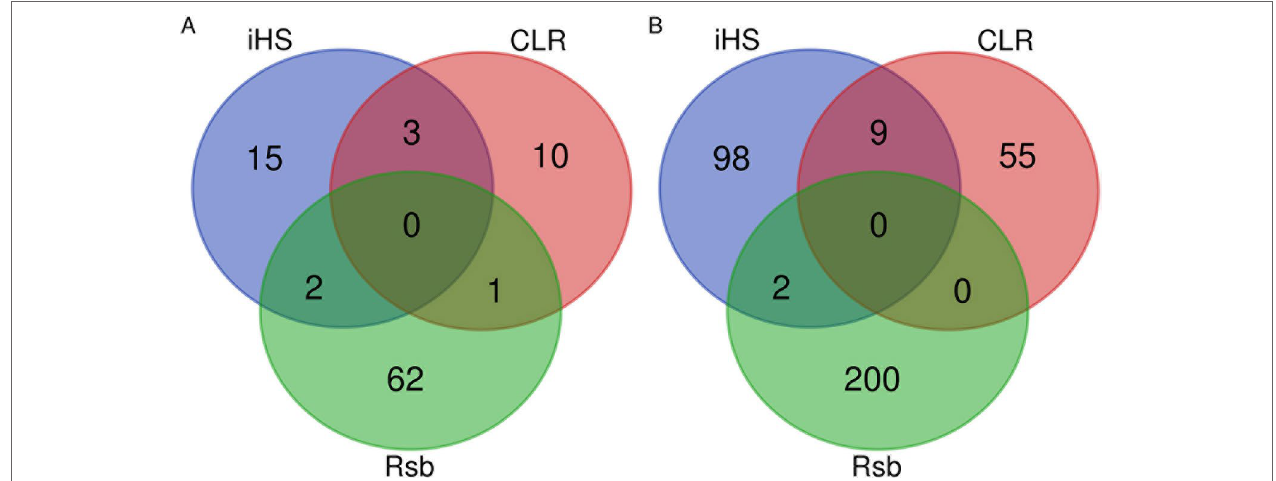
FIGURe 5 | Venn diagrams of the overlapping (A) genomic regions and (B) candidate genes identified by iHS , CLR, and Rsb .